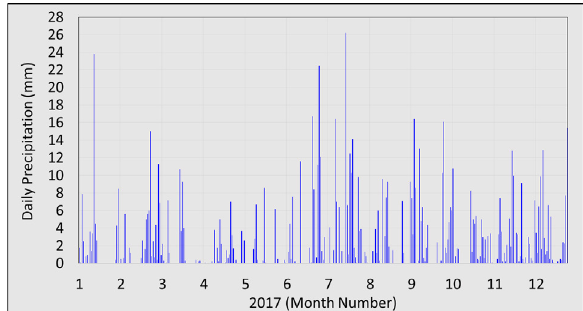
Figure 8. Daily precipitation (mm) measured at weather station – Groß Berßen (Figure 3) in 2017.